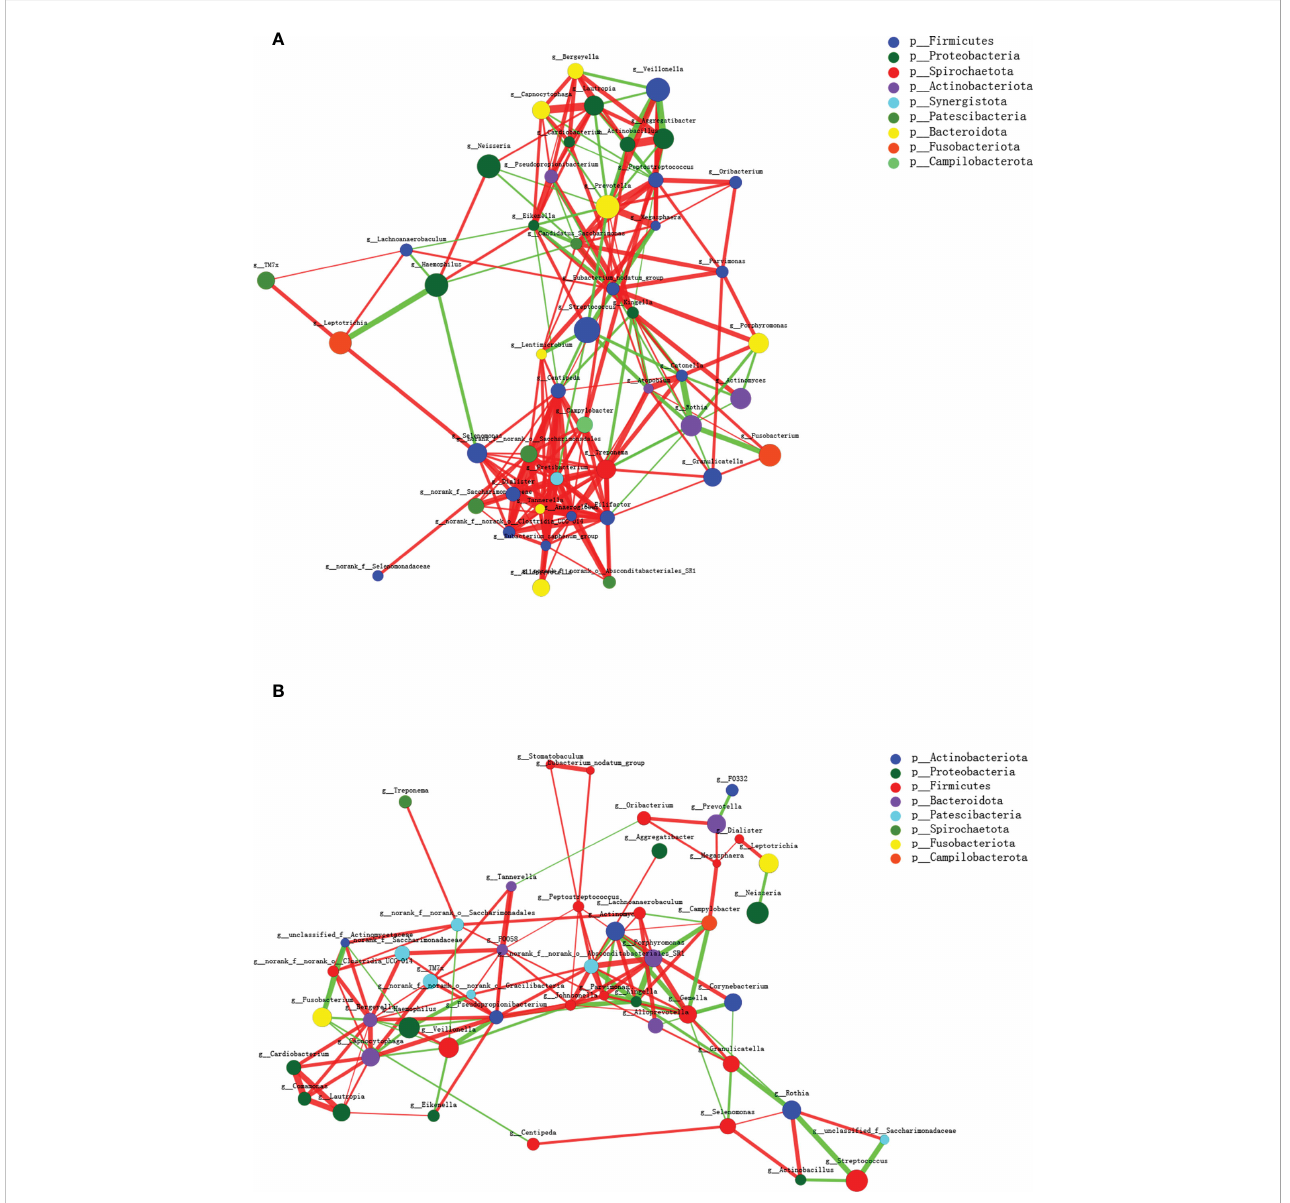
FIGURE 3 Microbial co-occurrence networks of the top 50 abundant genera constructed on the MAFLD (A) and control (B) groups. Each node represents a genus, and the size of the node is proportional to the mean relative abundance. The same color represents the genera belonging to the same phylum. The thickness of each connection is proportional to the coef fi cient values. The red and green lines indicate positive and negative interactions,